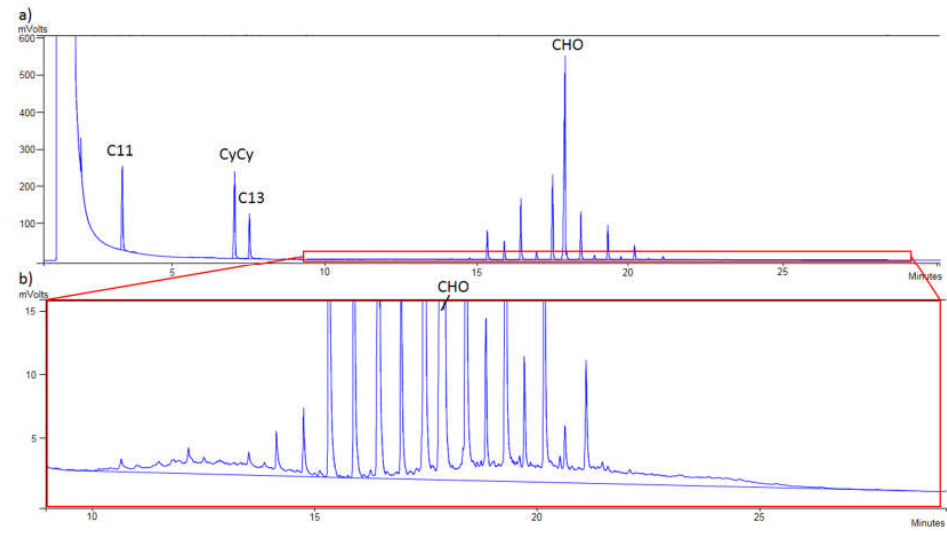
Figure 3. ( a ) Chromatogram of mineral oil saturated hydrocarbons (MOSH) of the sample of refined olive oil 6 contaminated at 8.2 mg/kg; (C11: n -undecane; CyCy: bicyclohexyl; C13: n -tridecane; CHO: cholestane). ( b ) Zoomed-in from (a) (CHO: cholestane).